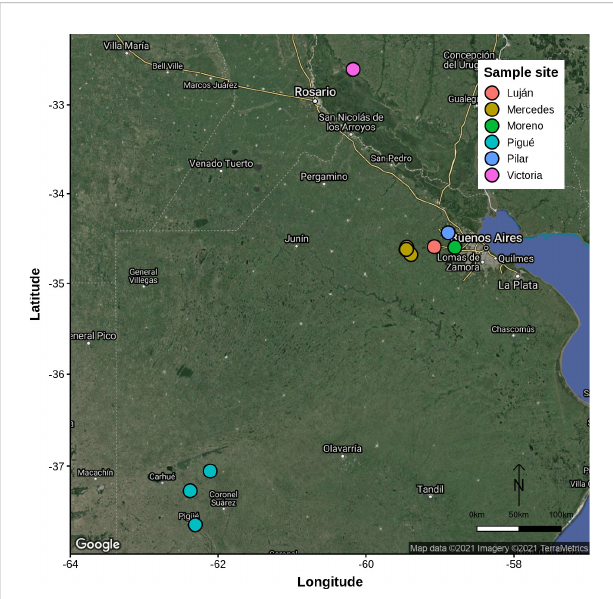
FIGURE 1 Map of Buenos Aires province indicating the geographical positions of the sampling